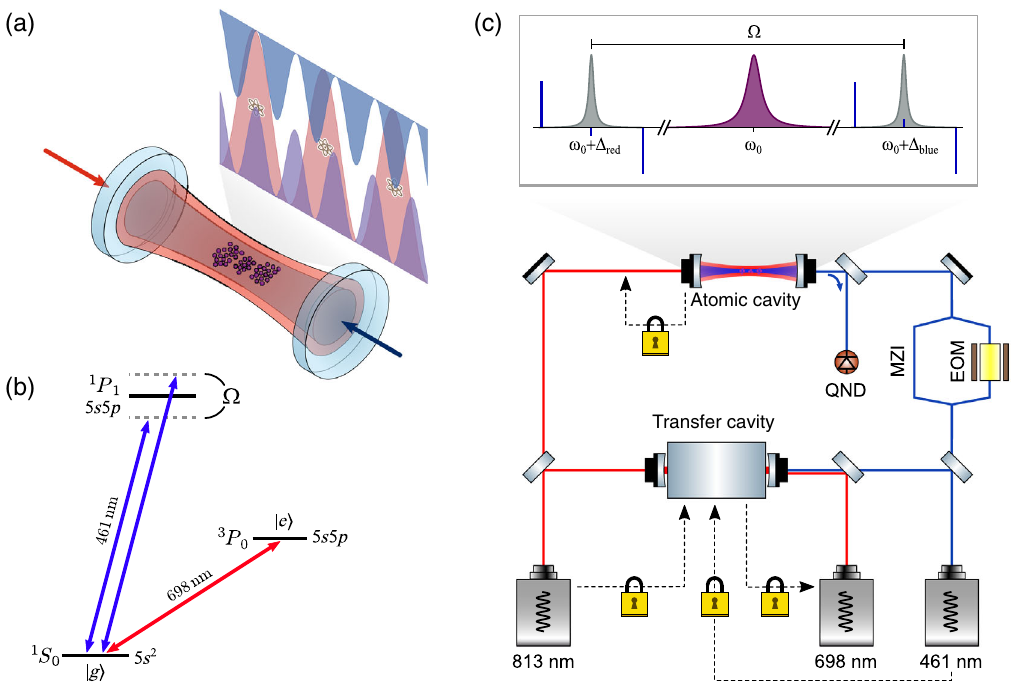
FIG. 1. Overview of the QND measurement scheme. (a) Sketch of the dual-wavelength in-vacuum cavity used to trap the atoms and to carry out the QND measurement. Atoms are trapped at the 813 nm intensity maxima represented in red, while they also interact with the nearest blue- and red-detuned cavity modes at 461 nm represented in blue and purple. (b) Simplified level scheme for Sr showing the 461 nm transition used for nondestructive detection and the 698 nm optical clock transition. (c) Diagram of the optical setup used for the QND measurement, and a sketch of the optical spectrum transmitted through the Mach-Zehnder interferometer (MZI). The six probe frequency components generated by the electro-optic modulator (EOM) chain are depicted in blue, interacting with the cavity modes in gray which surround the atomic transition in purple. The padlocks represent Pound-Drever-Hall loops used to stabilize the laser frequencies and the cavity